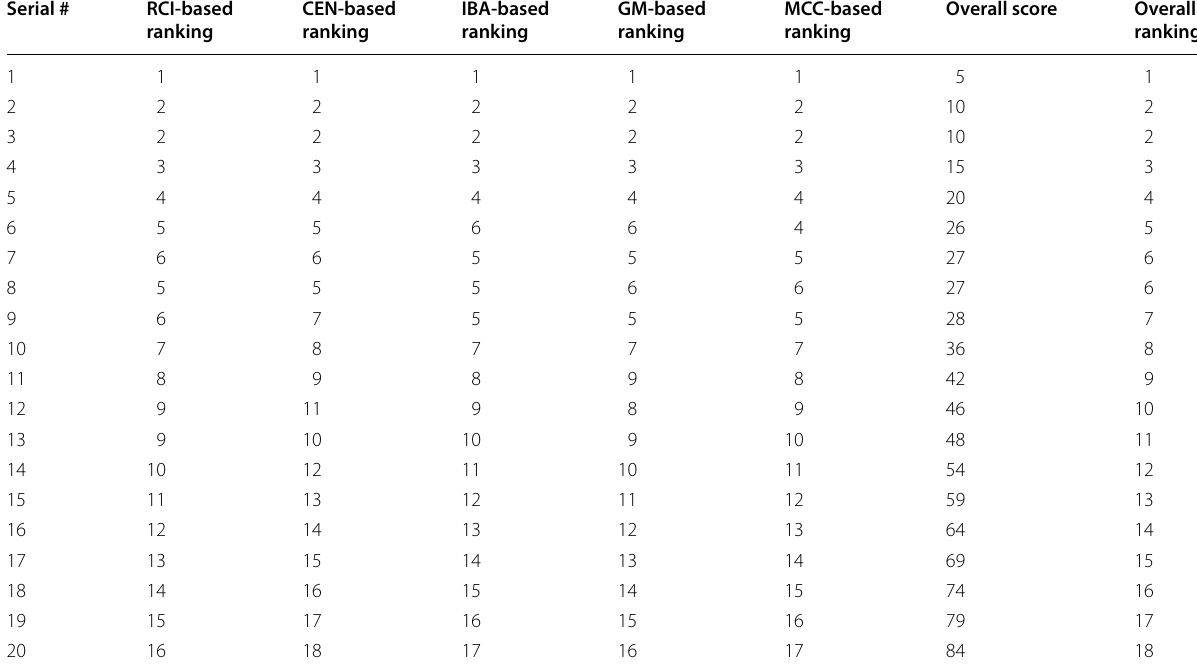
Table 8 Ranking of the